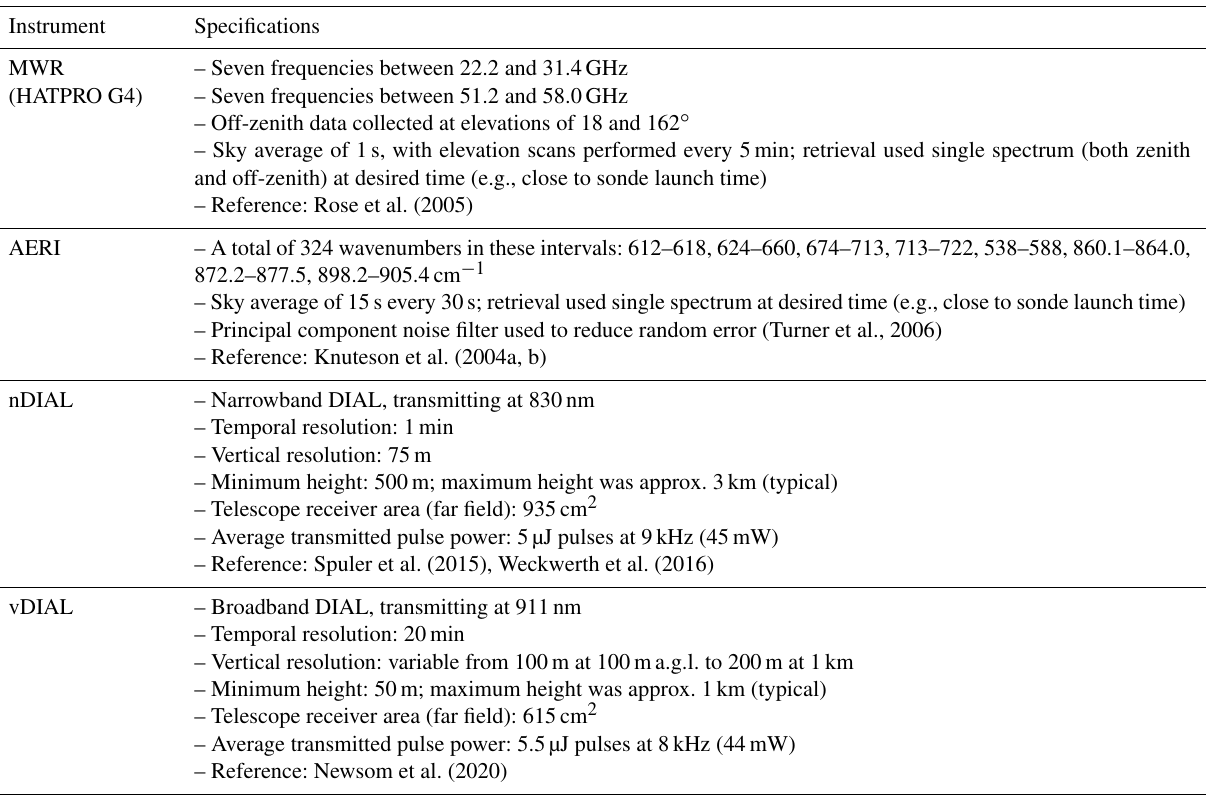
Table 1. Important specifications of the instruments used in this paper.